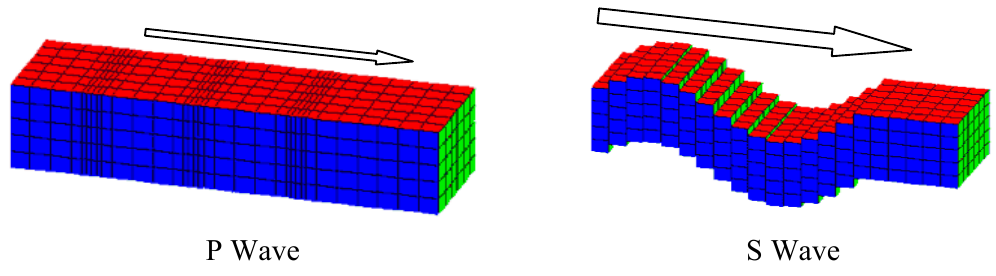
Figure 1. Primary and secondary